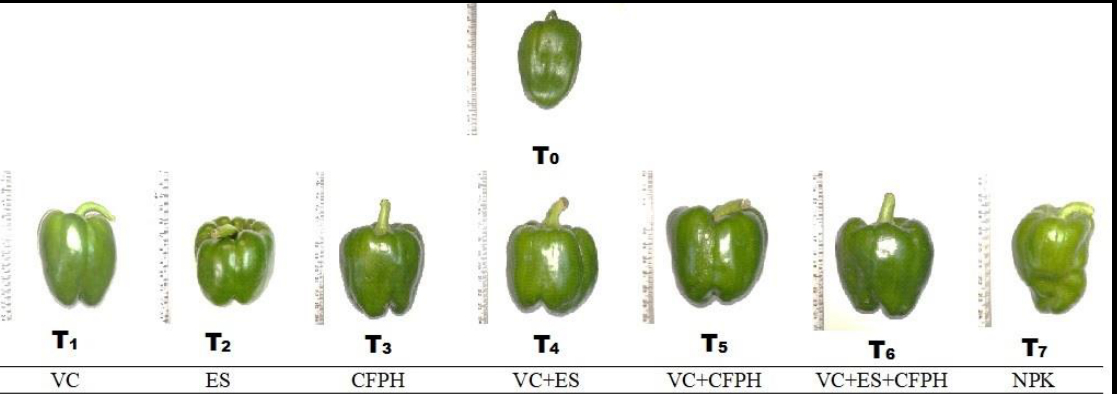
Fig. 4 Influence of different treatment on fruit size as compared to control; T 0 - Control; T 1, T 2, T 3, T 4, T 5, T 6 and T 7 - treatments VC- vermicompost; CFPH- chicken feather protein hydrolysate; ES- egg shell; NPK-chemical